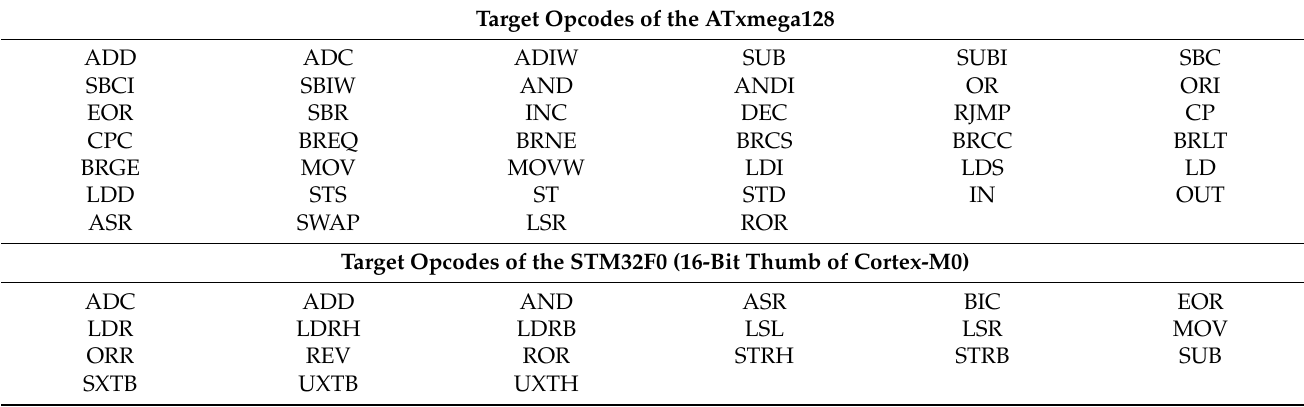
Table 1. Target opcodes of the ATxmega128 and the STM32F0 (Cortex-M0). Target Opcodes of the ATxmega128